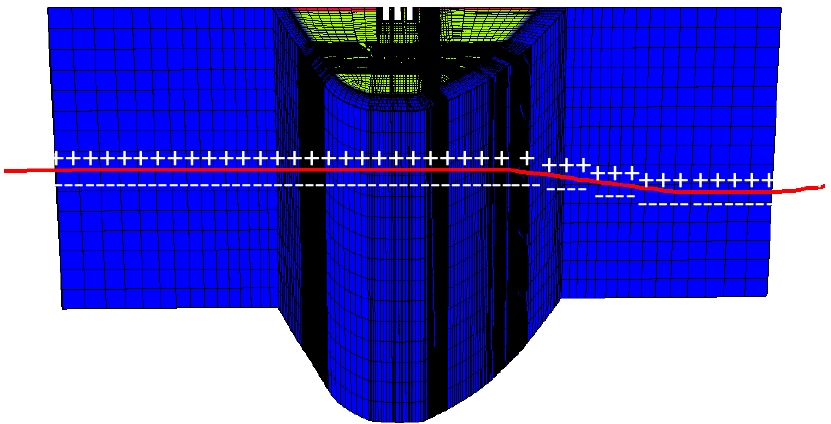
Figure 2. Arbitrary curve cutting